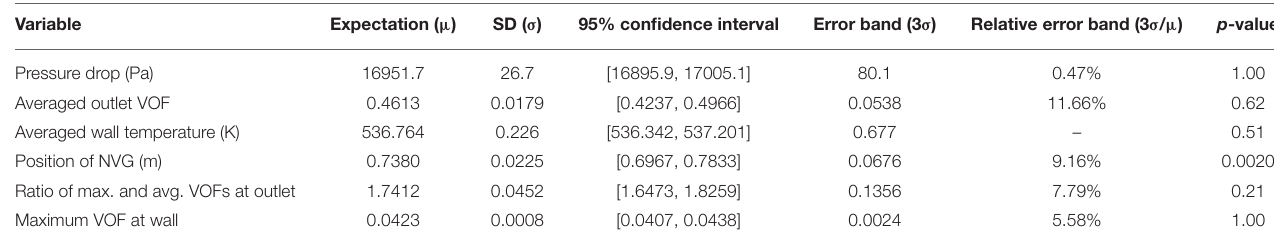
TABLE 2 | Statistical characteristics for the